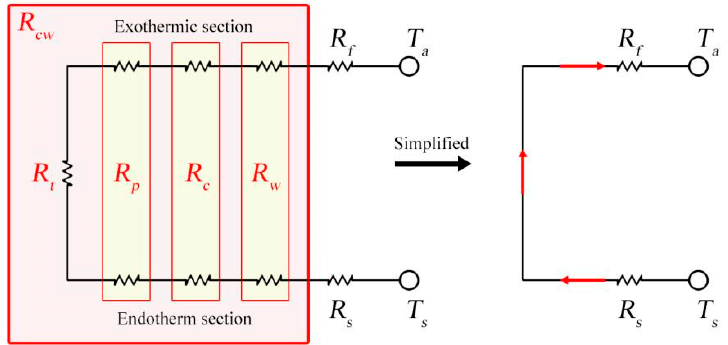
Figure 5. Heat transfer process of the HTD.